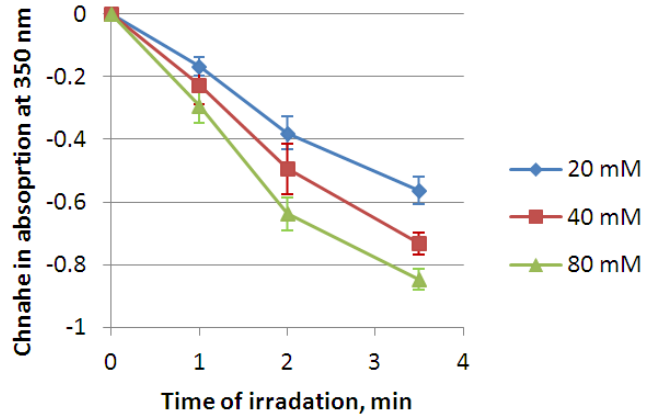
Figure 4. Changes in absorption iron(III) cations at 350 nm in iron(III) cross-linked